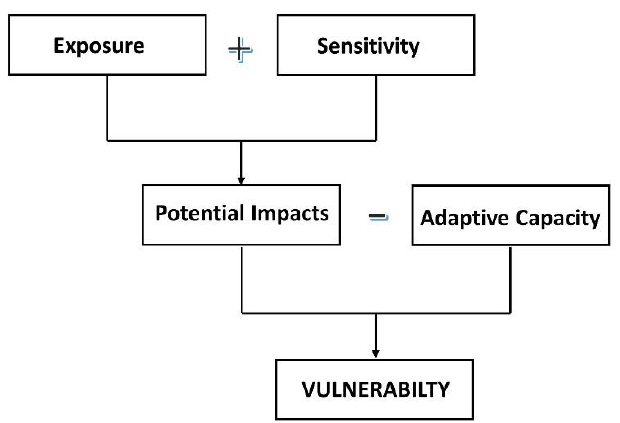
Figure 2. Vulnerability assessment framework used in this study.